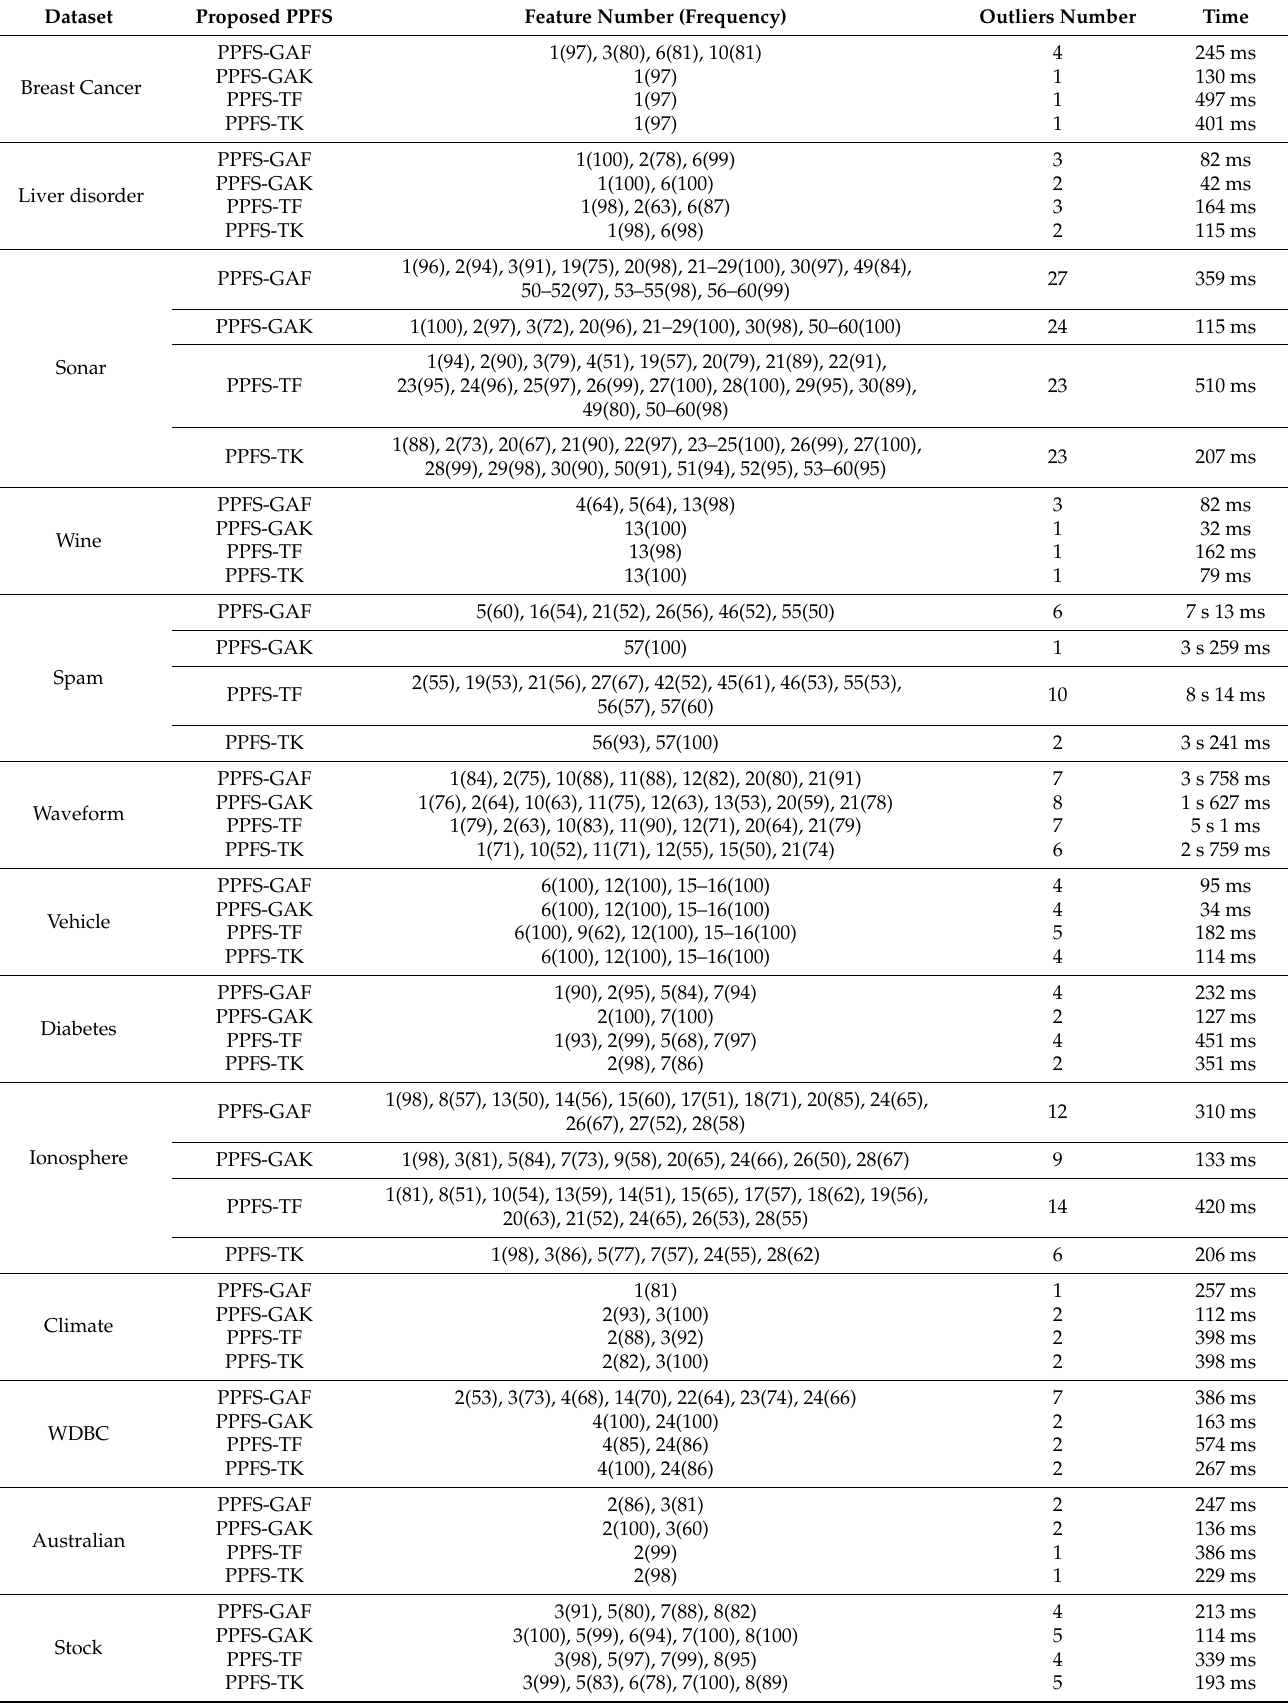
Table 5. The features (outliers) detected by the four proposed PPFS methods for the 19 datasets.